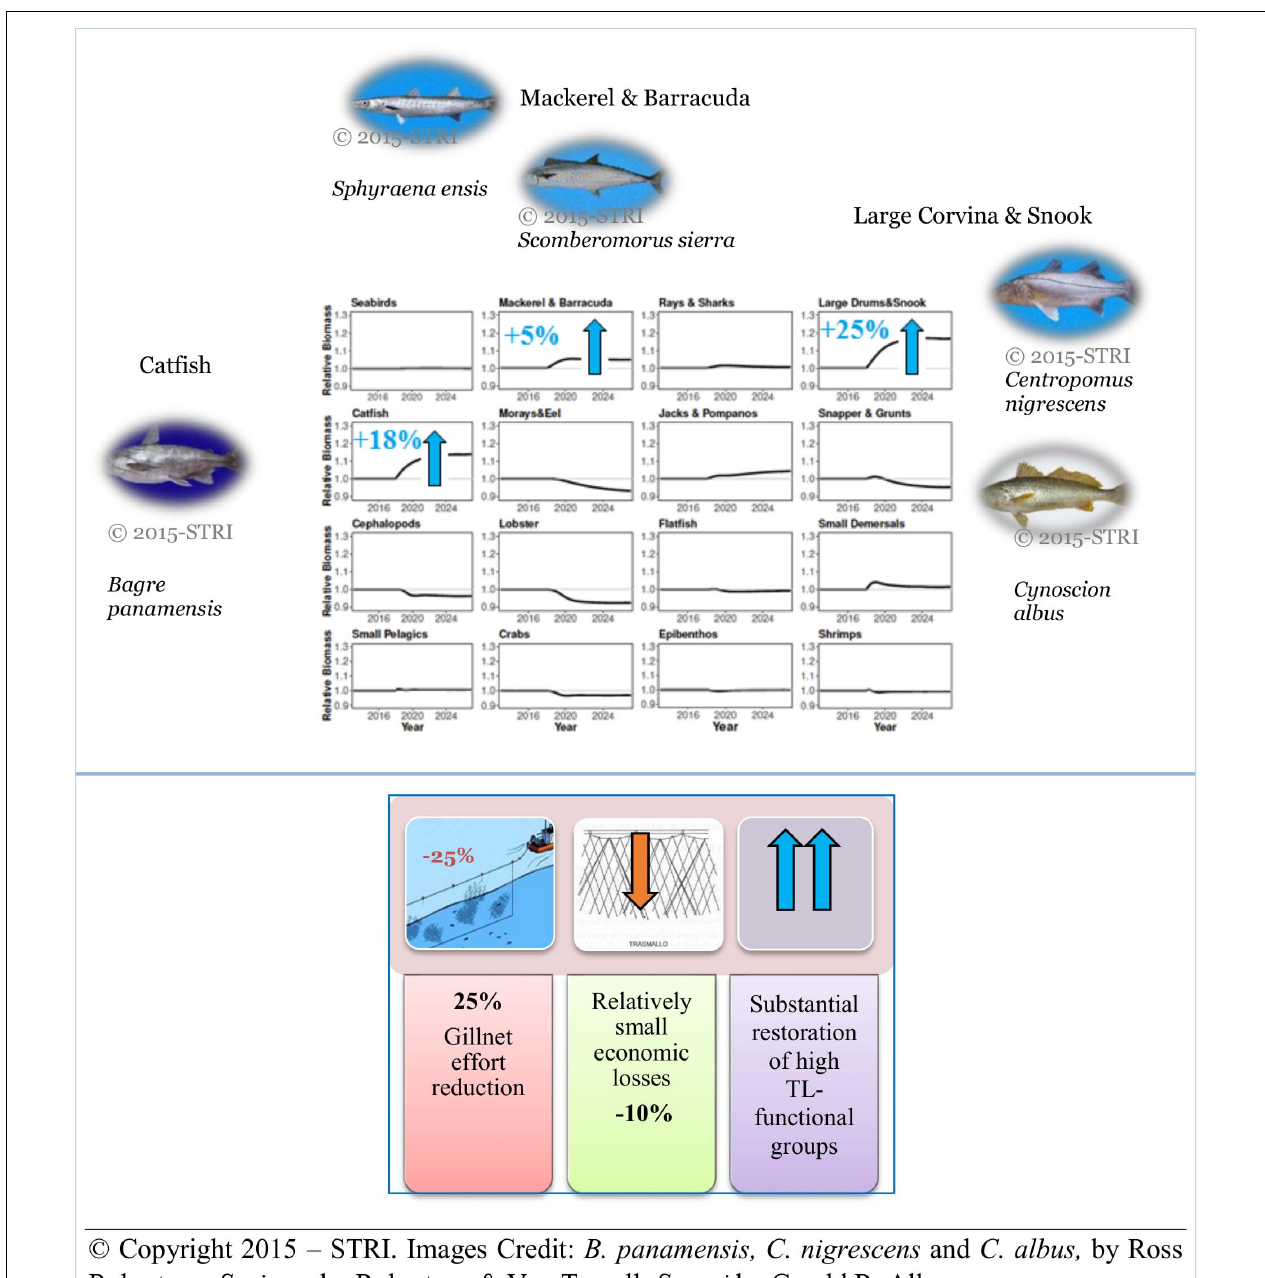
FIGURE 3 | Scenario 25% effort reduction was delivered to the members of an ecosystem-based intervention (lecture containing EwE models), based on Alms and Wolff (2019).